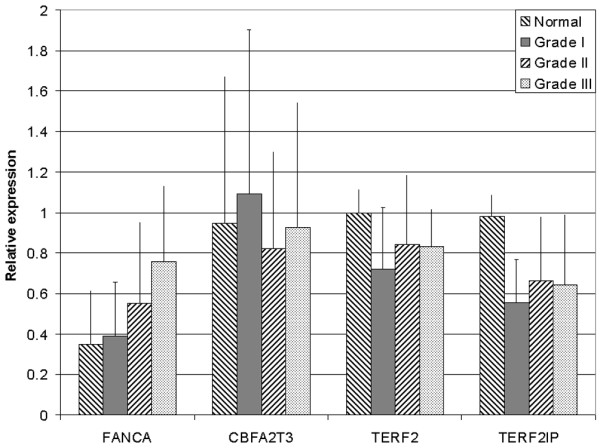
Quantitative reverse transcriptase PCR expression analysis in breast tumours according to tumour grade.